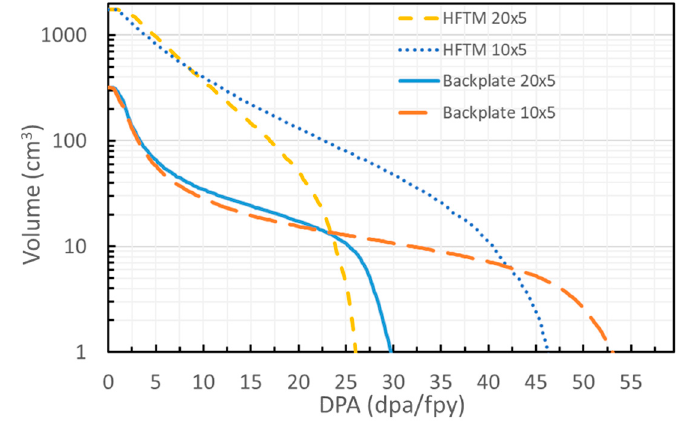
Figure 11. Integral volume (cm 3 ) over the DPA value.